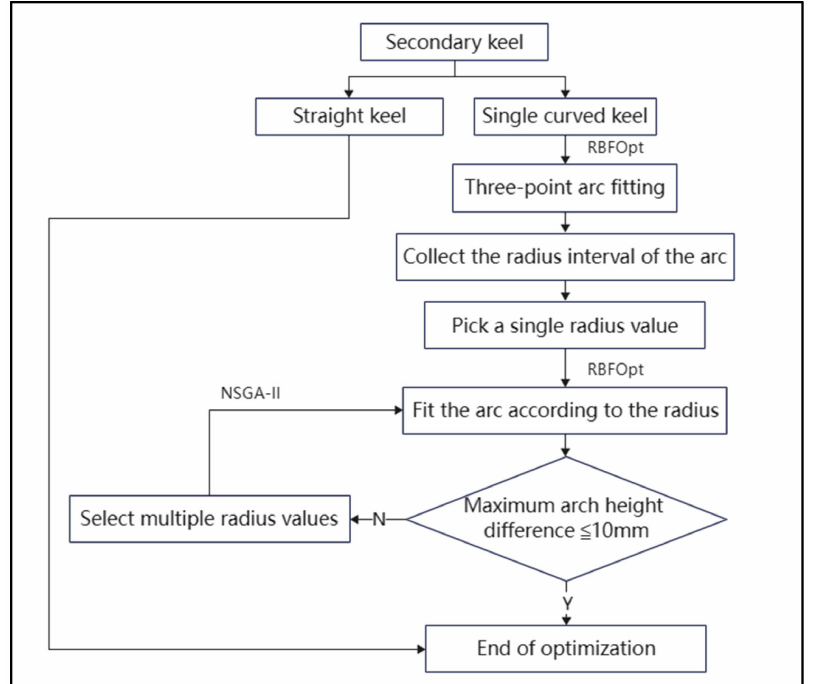
Figure 1. Keel optimization process in the comprehensive optimization